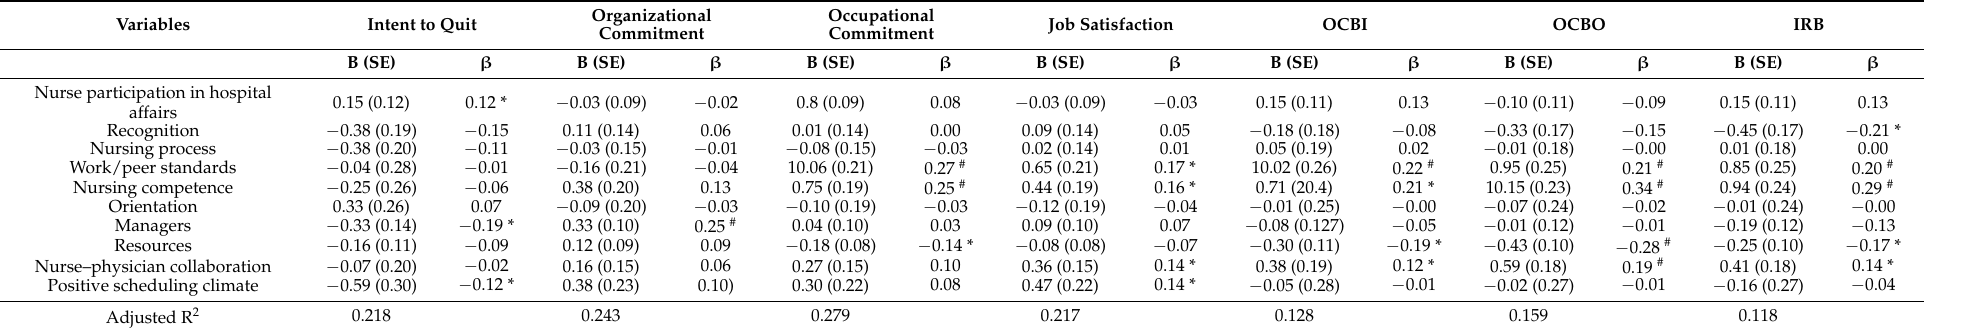
Table 4. Summary of regression analyses using the revised model scales as